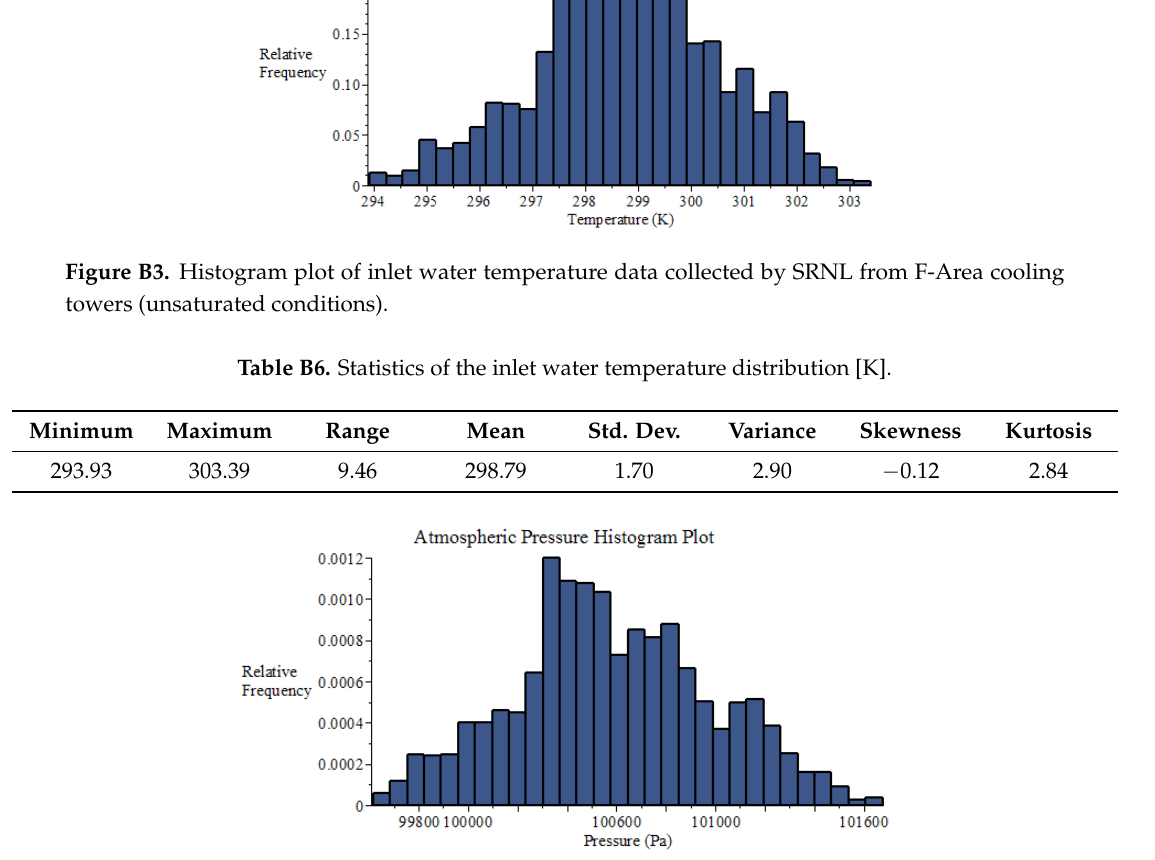
Figure B4. Histogram plot of atmospheric pressure data collected by SRNL from F-Area cooling towers (unsaturated conditions). Table B7. Statistics of the atmospheric pressure distribution [Pa].